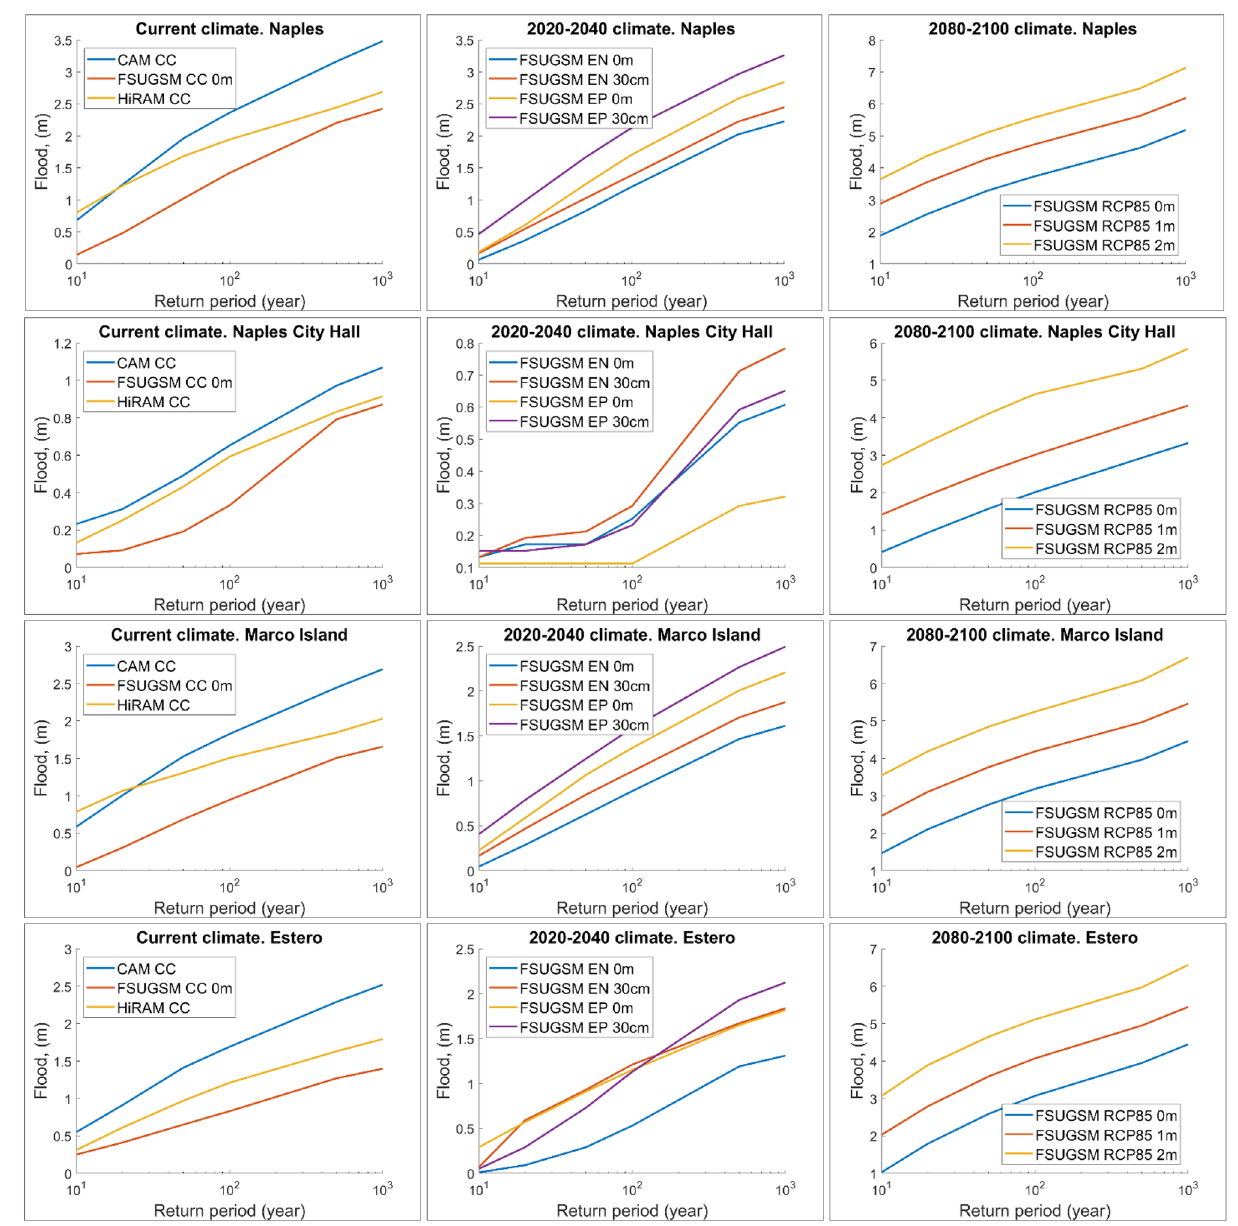
Figure 4. The water level at Naples tide gauge (top row), and inundation height at Naples City Hall (second row), March Island (third row), and Estero (bottom row) during current climate (left column), Early twenty- first Century (middle column), and late twenty-first century (right column). Predictions by CAM5.1, HiRAM- GFDL, and FSUGSM-WRF for the current climate are presented. Future inundation heights are based on FSUGSM-WRF